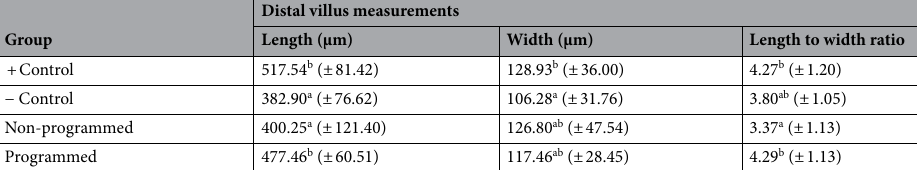
Table 5. Treatment effect on the villus measurements in the distal portion of the intestine. Values are presented as means (± std. dev). Superscript letters indicate statistical significance between groups. The significance was determined using a One-Way ANOVA and a Tukey test with a p value <